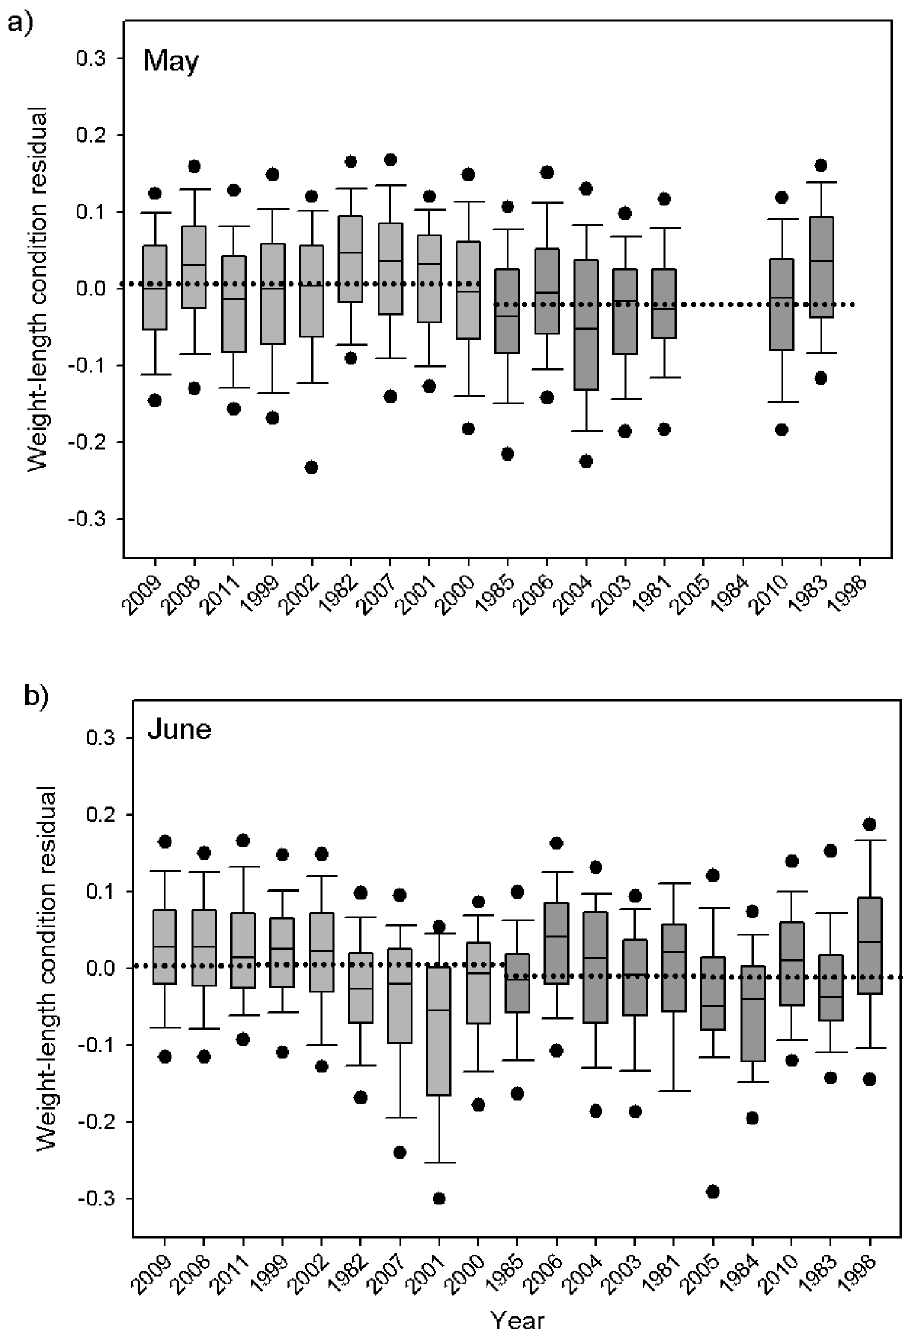
Fig 6. Average juvenile yearling Chinook salmon annual weight-length condition residual for May (a) and June (b). The x-axis years are ranked by average spring Pacific Decadal Oscillation (low to high). Shown are boxplots with the median (lines in boxes), 25th and 75th percentiles (lower and upper ends of boxes), 10th and 90th percentiles (error bars), and 5th and 95th percentiles (points) for each year. Light grey bars designate cold years, and darker grey bars designate warm years with dotted line representing regime